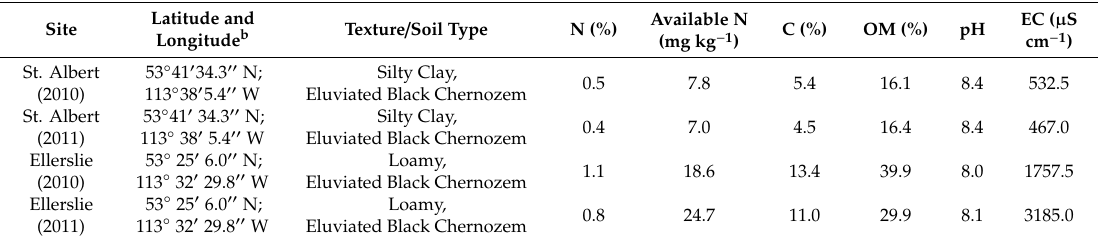
Table 2. Physical site (i.e., soil) characteristics of short-term dose trials, as sampled in May 2010 and 2011. Values represent the average of 10 soil cores collected at 0–30 cm depth. All sites were level with negligible